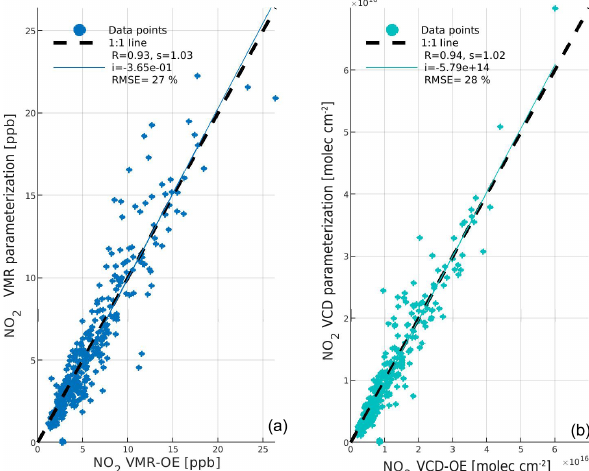
Figure 5. Visible range: comparison between (a) MMF and param- eterized NO 2 near-surface VMR as well as (b) MMF and parame- terized NO 2